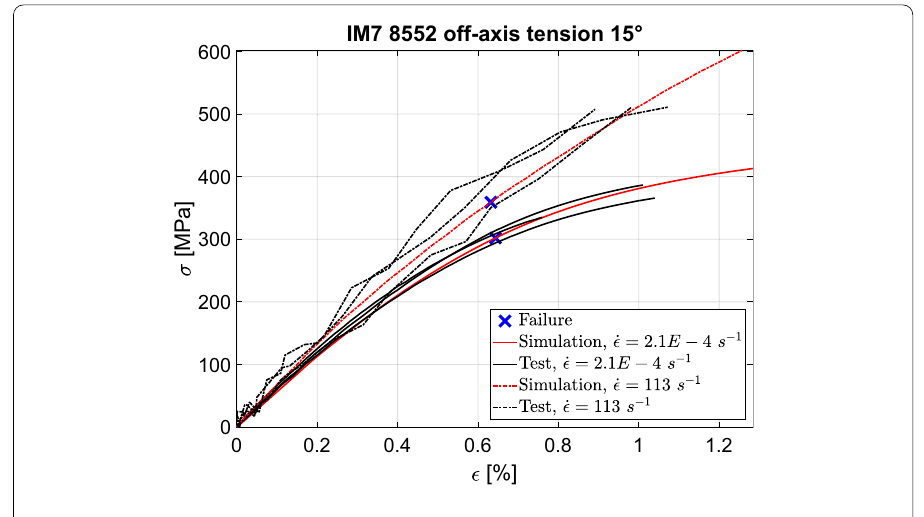
Fig. 12 True stress–true strain curves for the tensile tests and simulations, 15 ◦